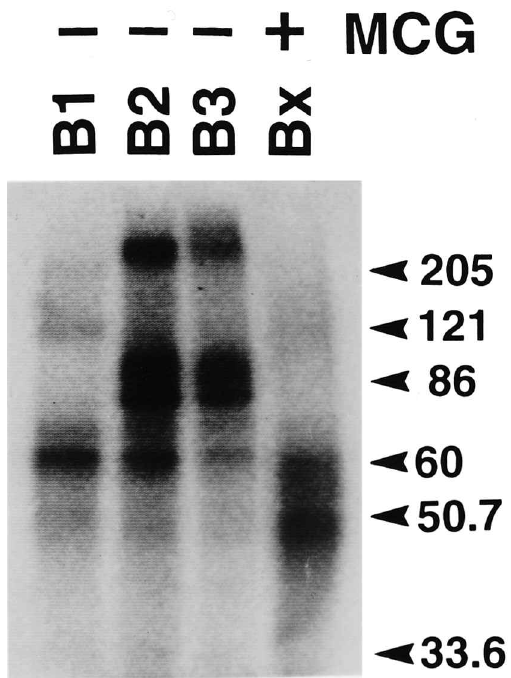
FIG. 3. UV-crosslinked NF- k B proteins of J774 cells. J774 cells were incubated for 3h at 37°C without or with purified MCG at the ratio of J774 cell to mast cell equivalent of 5 to 1. They were then exposed to LPS (10ng/ml) for 30min at 37°C. The nuclear proteins extracted from the cells were subjected to UV crosslinking using 32 P-labelled bromodeoxyuridine sub- stituted HIV NF- k B oligonucleotide as described in the Materials and Methods section. UV-crosslinked NF- k B1, B2, B3 and Bx eluted from the EMSA gel were analyzed by SDS- PAGE. The arrows indicating 60 and 50.7 are UV-crosslinked NF- k Bx proteins. A similar result was obtained by an additional experiment.